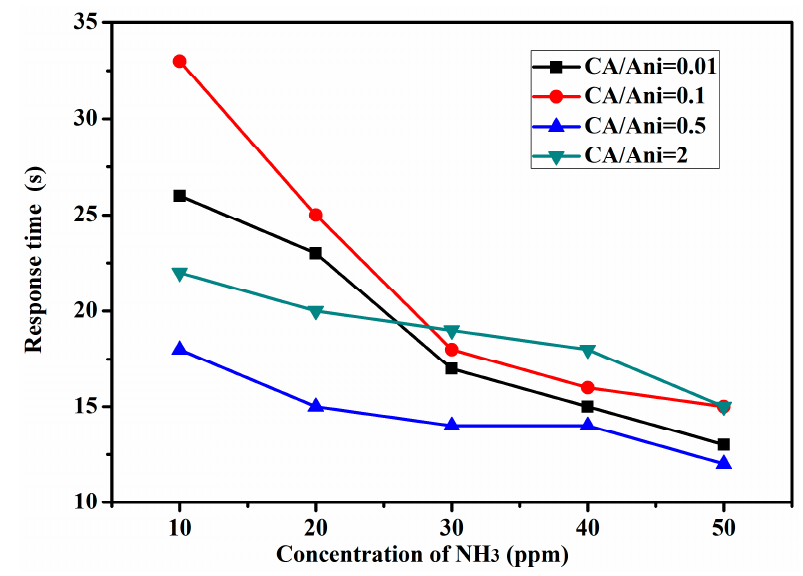
Figure 8. Response time the sensors deposited with PANI nanomaterials with different morphologies to ammonia ranging from 10 to 50 ppm at room temperature.